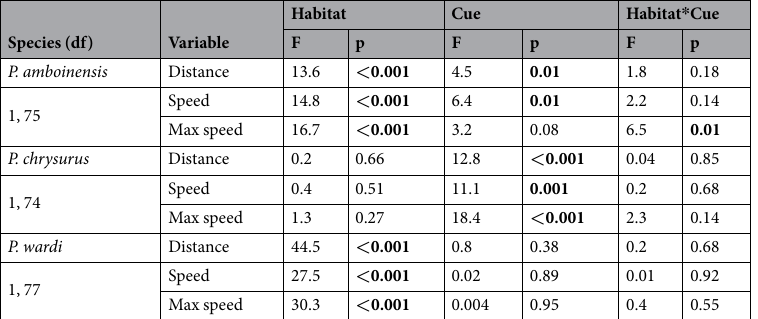
Table 2. Comparison of the fast-start response kinematics of three juvenile damselfishes that have been kept in seawater that has passed over live-healthy coral or dead-degraded coral (Habitat), and then either exposed to either clean seawater or conspecific alarm odours (Cues) within the burst arena just prior to being startled. Damselfish belong to the genus Pomacentrus . Results show the outcome of two-factor ANOVA’s on three kinematic variables: response distance (m), speed (m/s) and maximum speed (m/s). Bold values are significant at